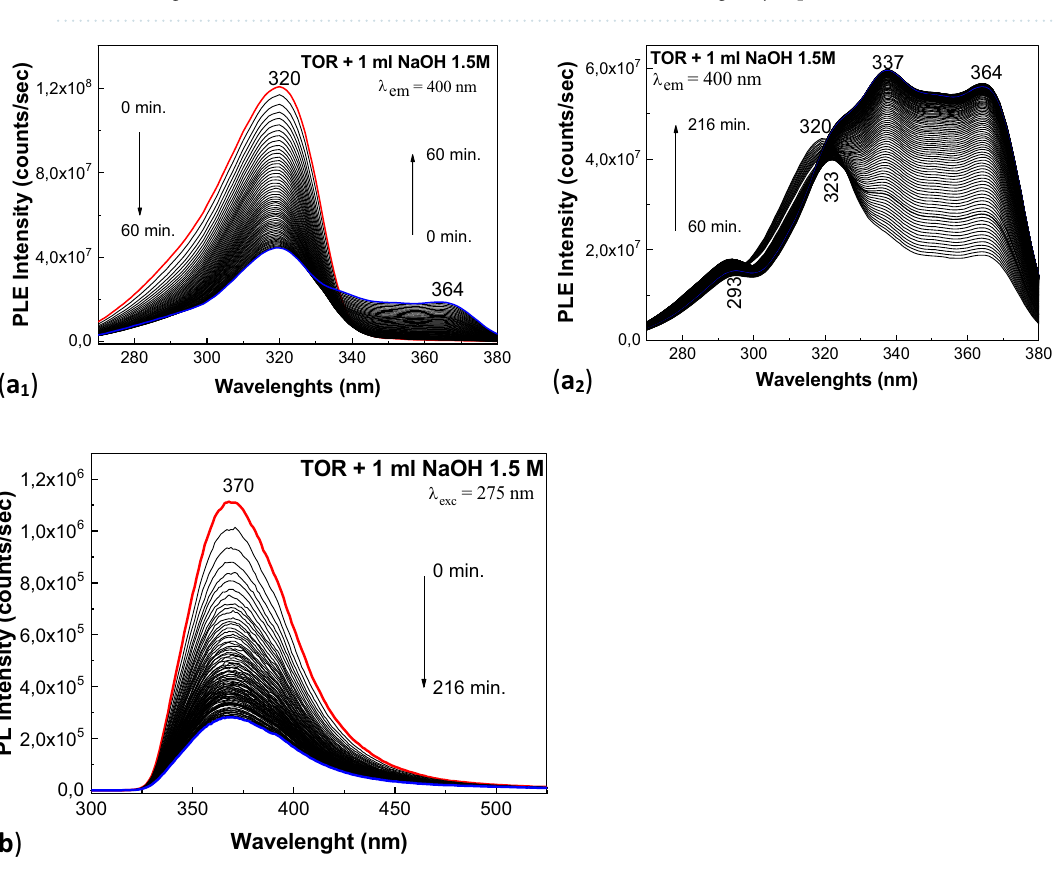
Figure 4. PLE ( a ) and PL ( b ) spectra of the aqueous solutions of ATC 2 mg/ml in the presence of excipients form the drug marked under the name TOR and the influence of the UV light by exposure for 216 min.